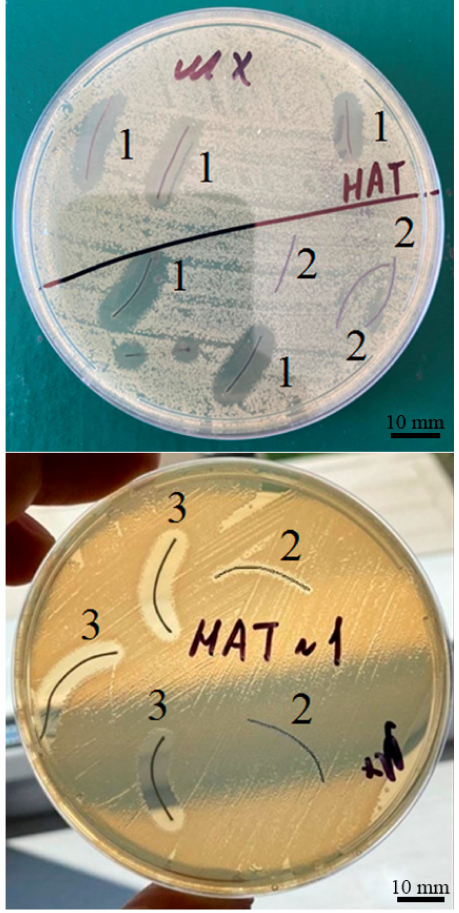
Figure 9. Inhibitory effect of silk fibers with AgNPs and with cyclic freezing/thawing (1) without AgNPs (2) with AgNPs and without cyclic freezing/thawing (3) against Escherichia coli bacteria by means of disc